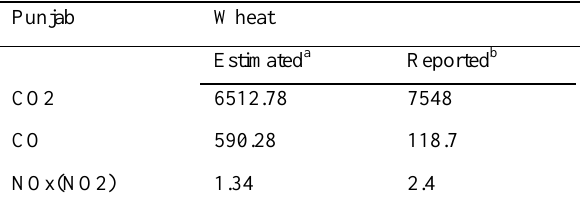
Table 9a. Comparison of the estimated total emissions with reported total emissions of GHGs in 2003 during wheat straw burning. a Estimation for the year 2003 (during wheat straw burning). b Estimates of wheat straw burning 2000 (Sahai et al., 2007).